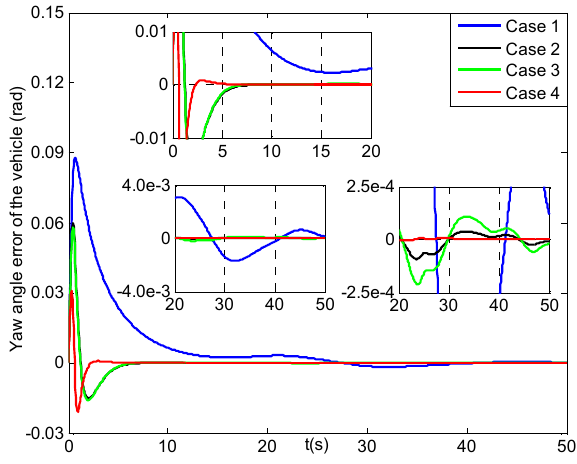
Figure 25. Yaw angle errors of the vehicle (four cases).